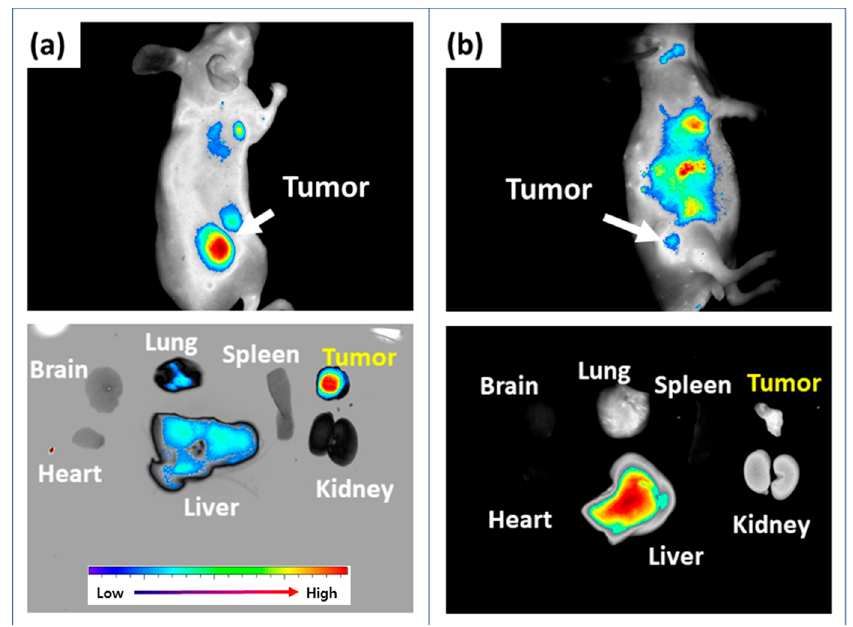
Figure 10. In vivo animal imaging using HCT116-bearing tumor xenograft mouse model. ( a ) Fluorescence imaging of tumor xenograft of HCT116 tumor. ( b ) The effect of pretreatment of HA on the fluorescence imaging of mouse. Ce6tetraHA nanophotosensitizers were i.v. administered (5.0 mg / kg) and then mice were observed under fluorescence 1 day later. For pretreatment of HA, HA (20 mg / kg) were i.v. administered 1h before nanophotosensitizer administration.